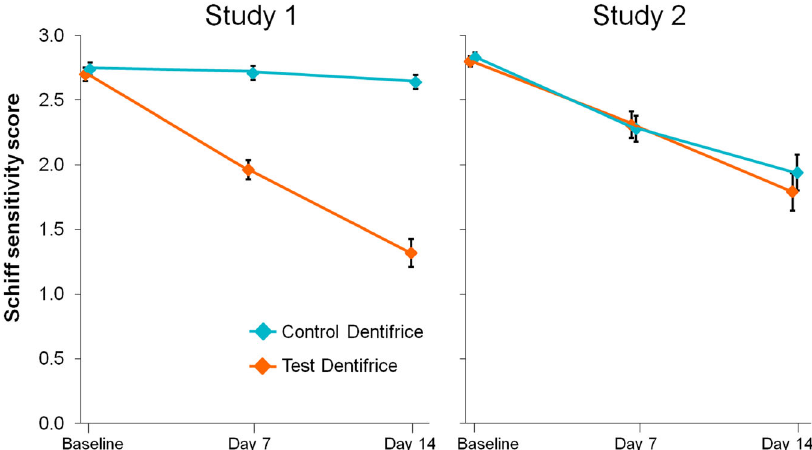
Fig. 2 Effect of treatments on Schiff sensitivity scores. Values are adjusted means (±SE). Data are offset for clarity. Low values are favourable.